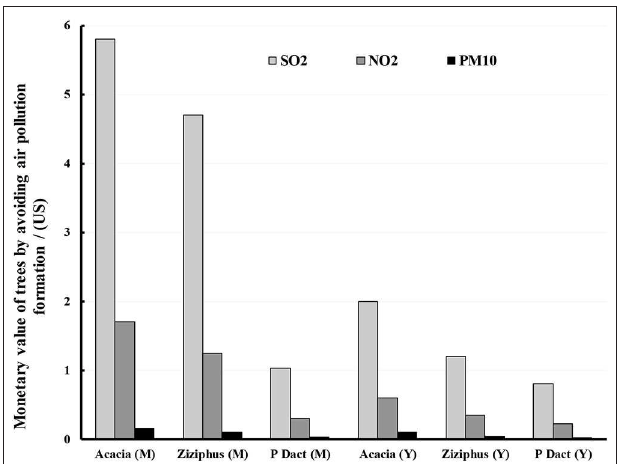
FIGURE 3 | The monetary value of air pollution removal on tree surfaces. “M” indicates mature trees with trunk diameter of 45 in. or greater, “Y” indicates young tress with trunk size of < 10 in, “P Dact” indicates Phoenix Dactylifera